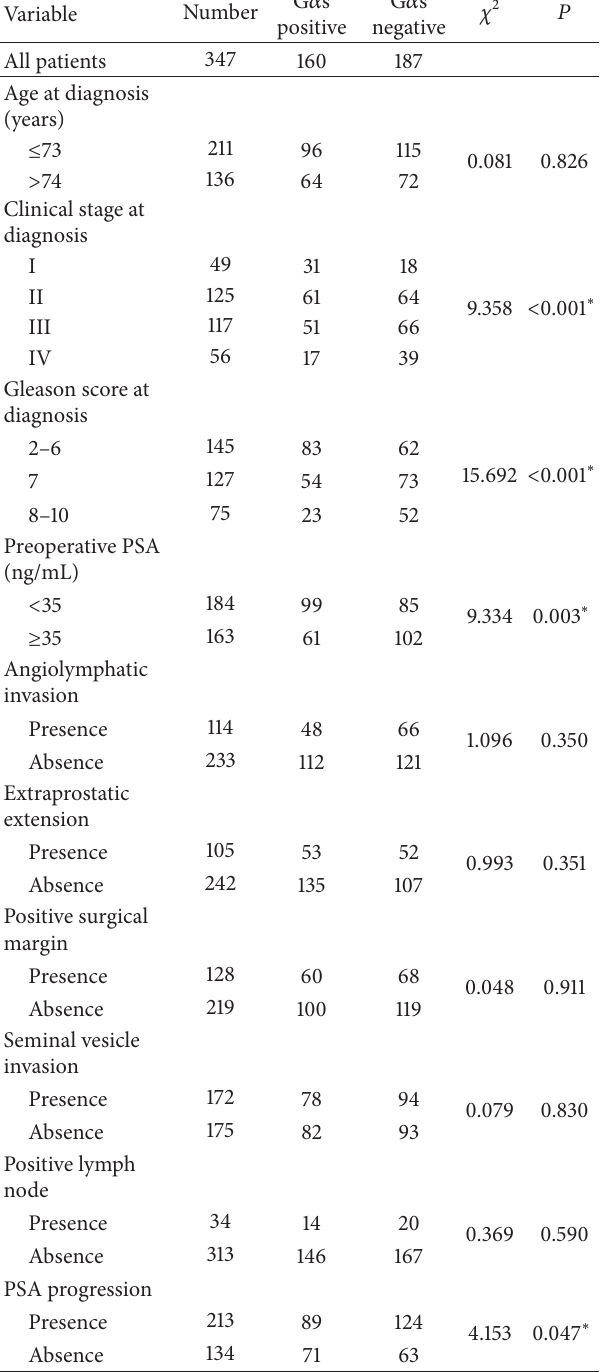
Table 1: Comparison of G 𝛼 s expression among different pathologi- cal categories.